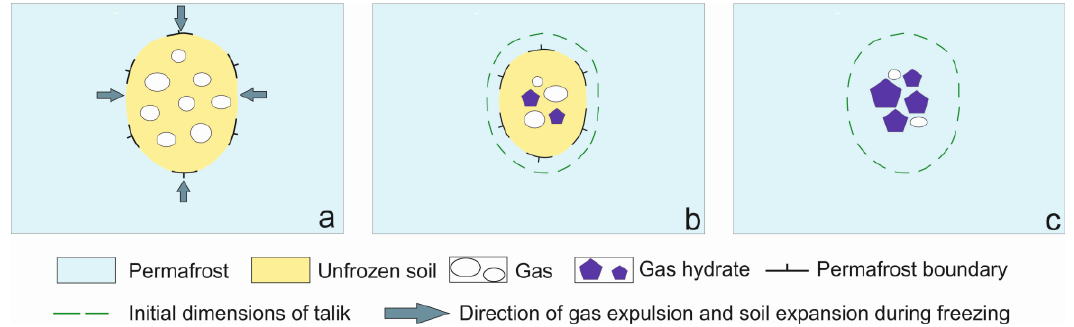
Figure 12. Pore hydrate formation in permafrost upon rapid freezing of a gas-saturated talik: ( a ) onset of cryogenic concentration of gas; ( b ) onset of hydrate formation upon freezing; and ( c ) hydrate formation at negative temperature.